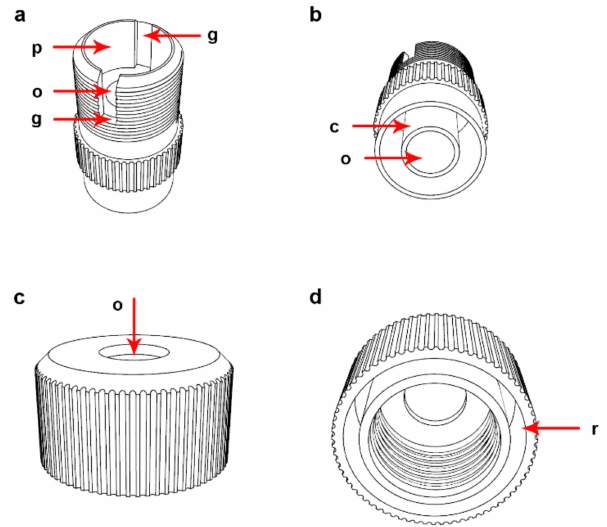
Figure 2. Description of the particular parts of the developed device. ( a ) The sample part of the holder. g—groove; o—opening at the bottom; p—place for the insertion of the support, coverslip, filter, insert, and the rubber seal. ( b ) The collection part of the holder. o—opening for drainage of solutions during processing of cell suspension; c—connector to vacuum pumps for solution removal. ( c ) The lid of the device. o—opening used for filling the device with cell suspension and for solutions filling and removal. ( d ) The lid of the device. r—recess for fixation of the device on the neck of the 50-mL centrifugation tube.